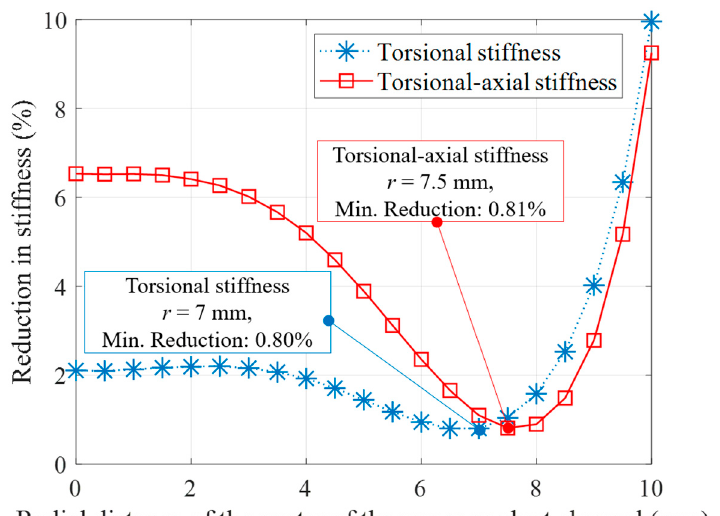
Figure 10. Reduction in torsional and torsional-axial stiffness versus the radial position of the upper coolant channel.